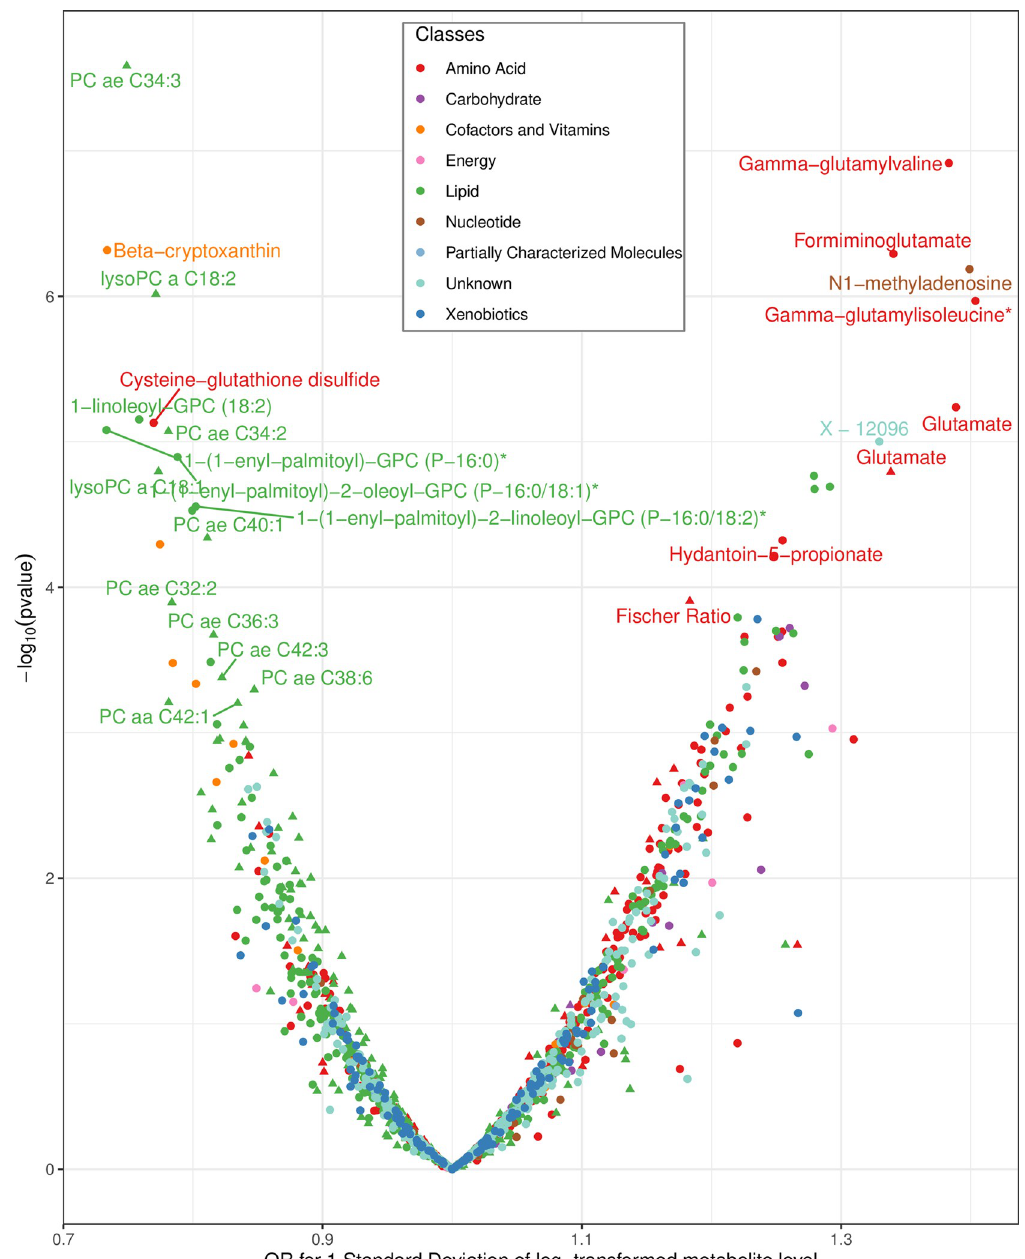
Fig 2. Volcano plot depicting the association between circulating metabolites measured by either Biocrates (triangles) or Metabolon (dots) with kidney cancer risk in 5 prospective cohorts. Metabolites that are labelled have a p -value below the threshold ( p < 0.05/ENTs) in the pooled analyses and are nominally significant in at least 2 cohorts separately. � Metabolite identity not yet confirmed by comparison with an authentic chemical standard. ORs and CIs were estimated for 1 SD of log- transformed metabolite levels by logistic regression conditioned on case set. Estimated ENT are 60 and 499 for Biocrates and Metabolon metabolites, respectively. p -Values threshold are thus 8.33E-04 and 1.00E-04 for Biocrates and Metabolon metabolites, respectively. CI, confidence interval; ENT, effective number of test; OR, odds ratio; SD, standard deviation.